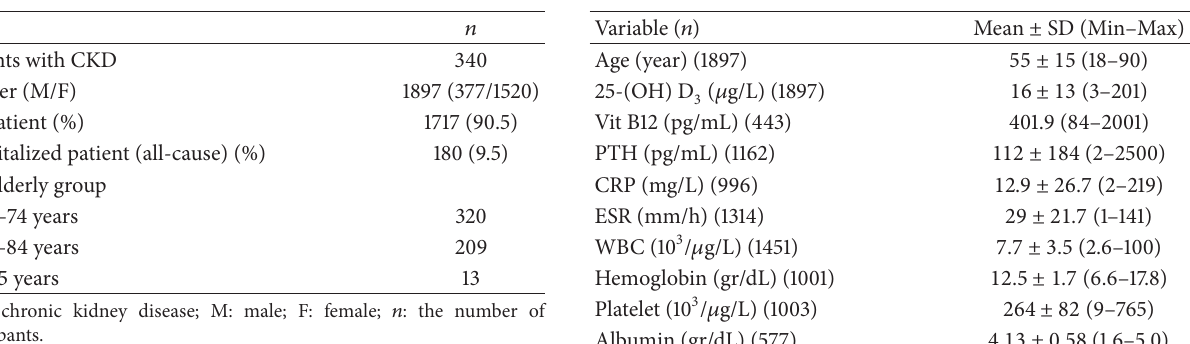
Table 1: Demographical data. Table 2: Clinical and laboratory data.